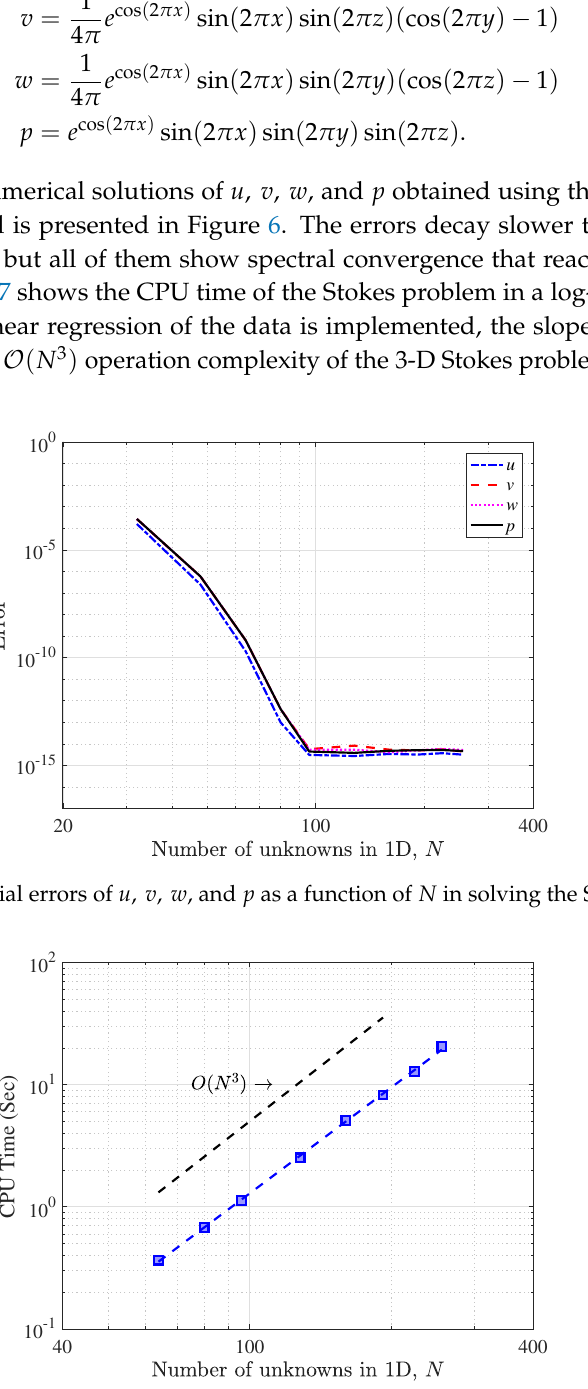
Figure 7. Blue markers show CPU times in solving the 3-D Stokes problem. The blue dashed line is plotted from the best linear regression of the blue markers’ data, where the slope is 2.884. The black dashed line shows O ( N 3 ) for